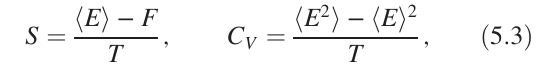
random Gaussian giant vortex, K =0 giant vortex, K =0.4